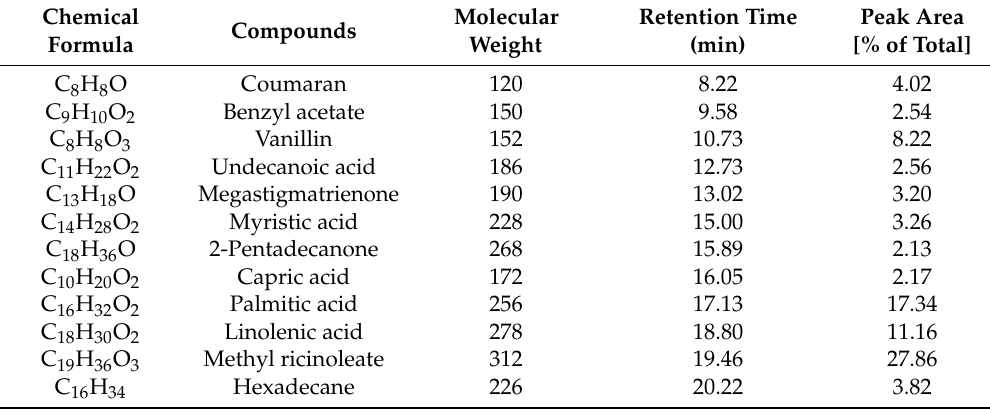
Molecular Retention Time Peak Area Weight (min) [% of Total]